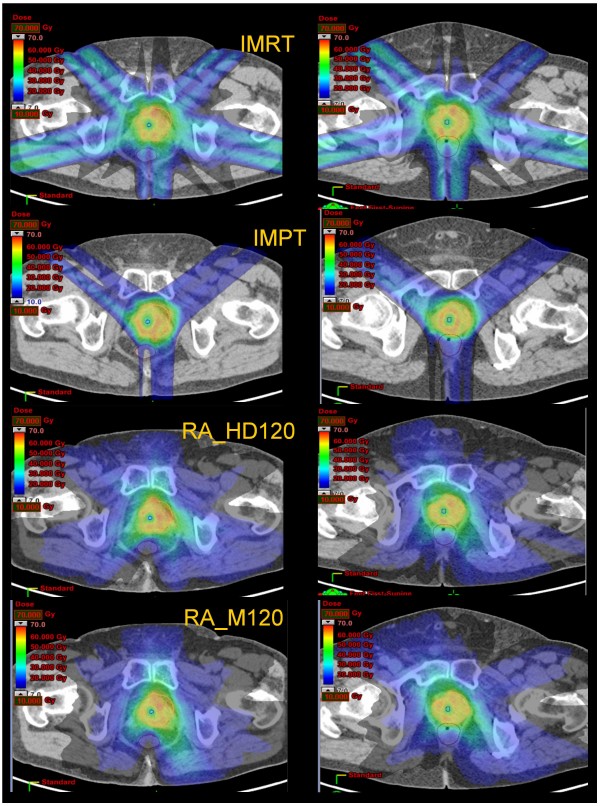
Color wash IMRT, IMPT, RA_HD120 and RA_M120 dose distributions for the planning target volume (PTV) for two patients with recurrent prostate cancer.